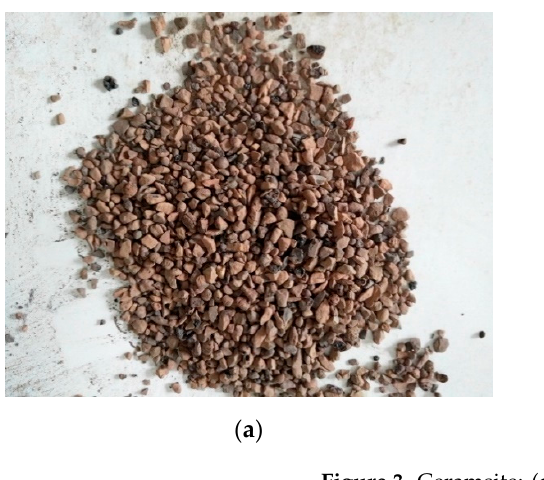
Figure 3. Ceramsite: ( a ) small; ( b ) large.